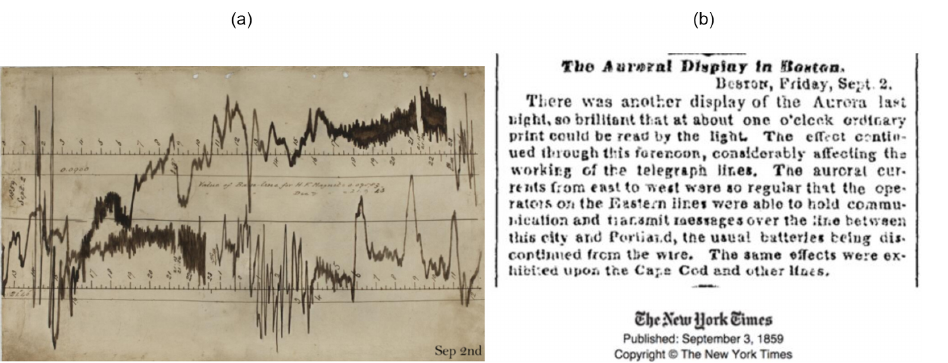
Figure 5. A magnetogram of one magnetic storm of 1859, known as the Carrington Event, the same event recorded at Greenwich Observatory in London (a) ; New York Times report on the same event (b)